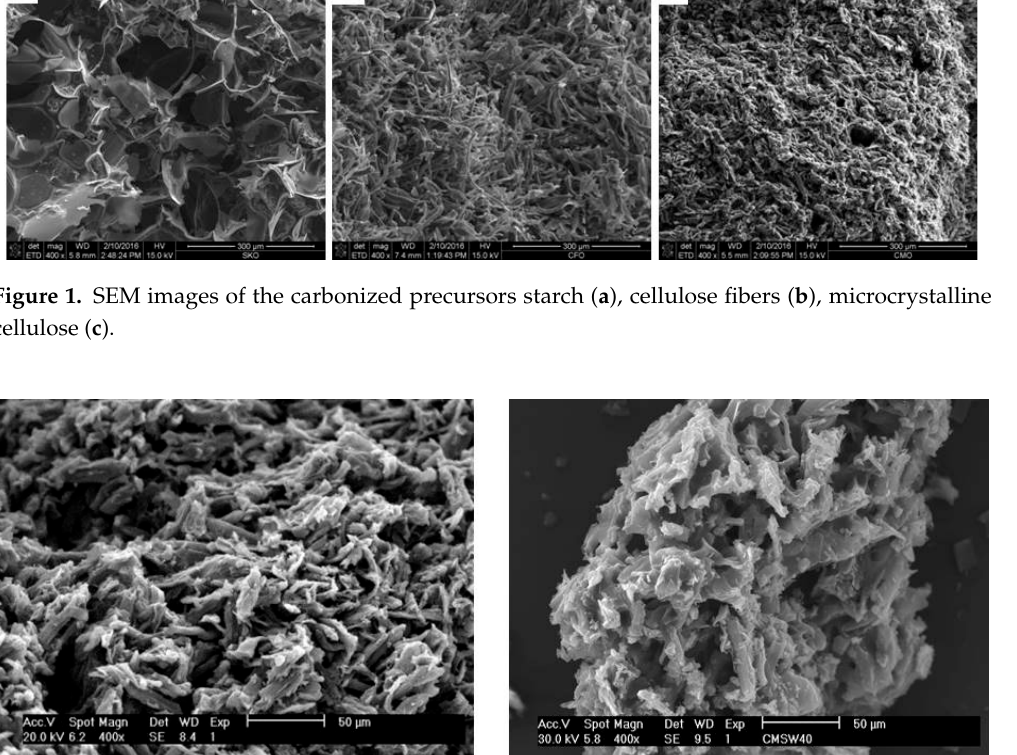
Figure 2 . SEM images of carbons from microcrystalline cellulose and different amounts of wheat starch: 10 wt. % ( left hand side ) and 40 wt. % ( right hand side ) .